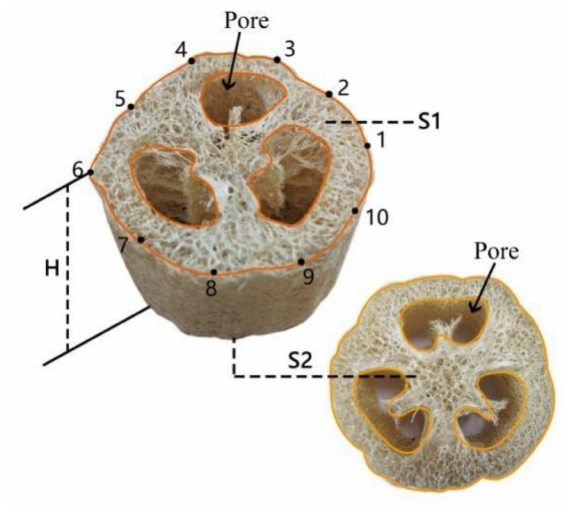
Figure 2. The method for testing the volume of luffa sponge